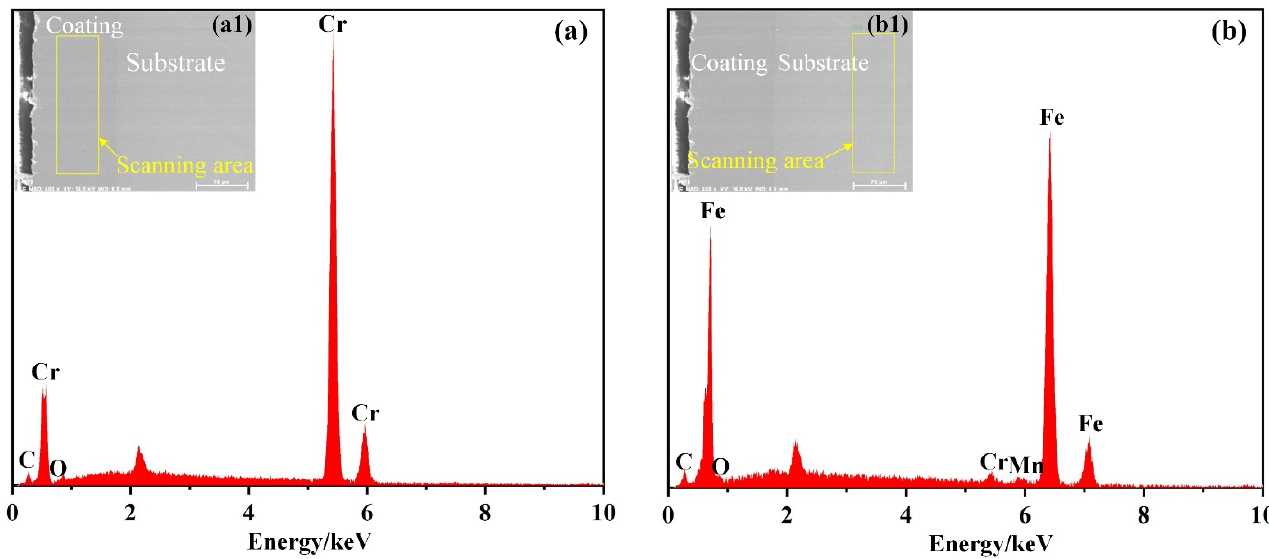
Figure 3. EDS analysis of the coating and substrate: ( a ) EDS analysis of the coating; ( a1 ) scanning area of the coating; ( b ) EDS analysis of the substrate; and ( b1 ) scanning area of the substrate.